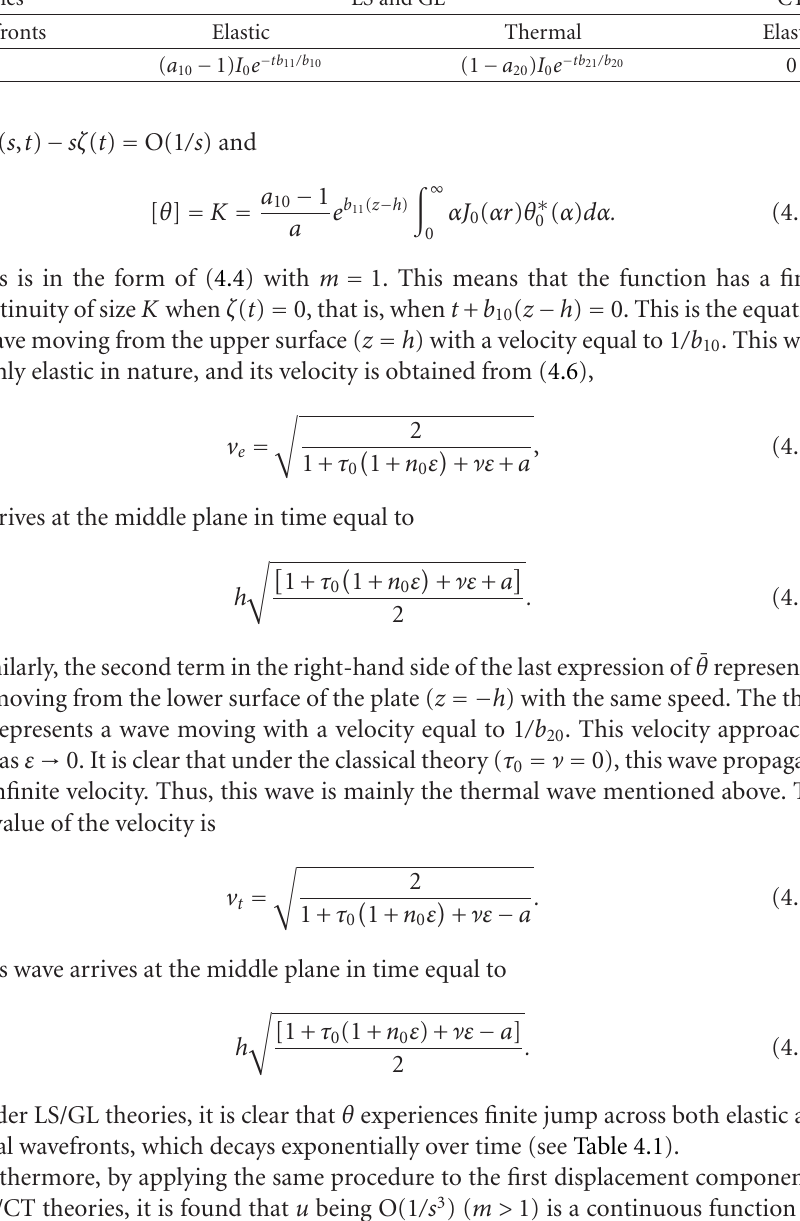
Table 4.1. Propagating discontinuities in θ , where I 0 = (1 /a ) Theories LS and GL CT Wavefronts Elastic Thermal